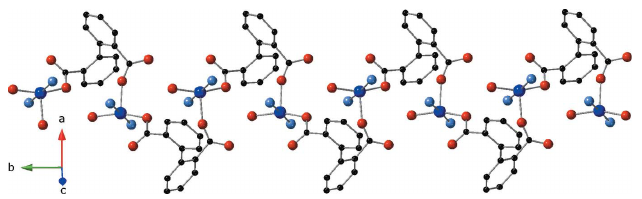
Figure 2 The [Cu(H 2 O)(dip)] n chain motif in the title compound, oriented parallel to b .